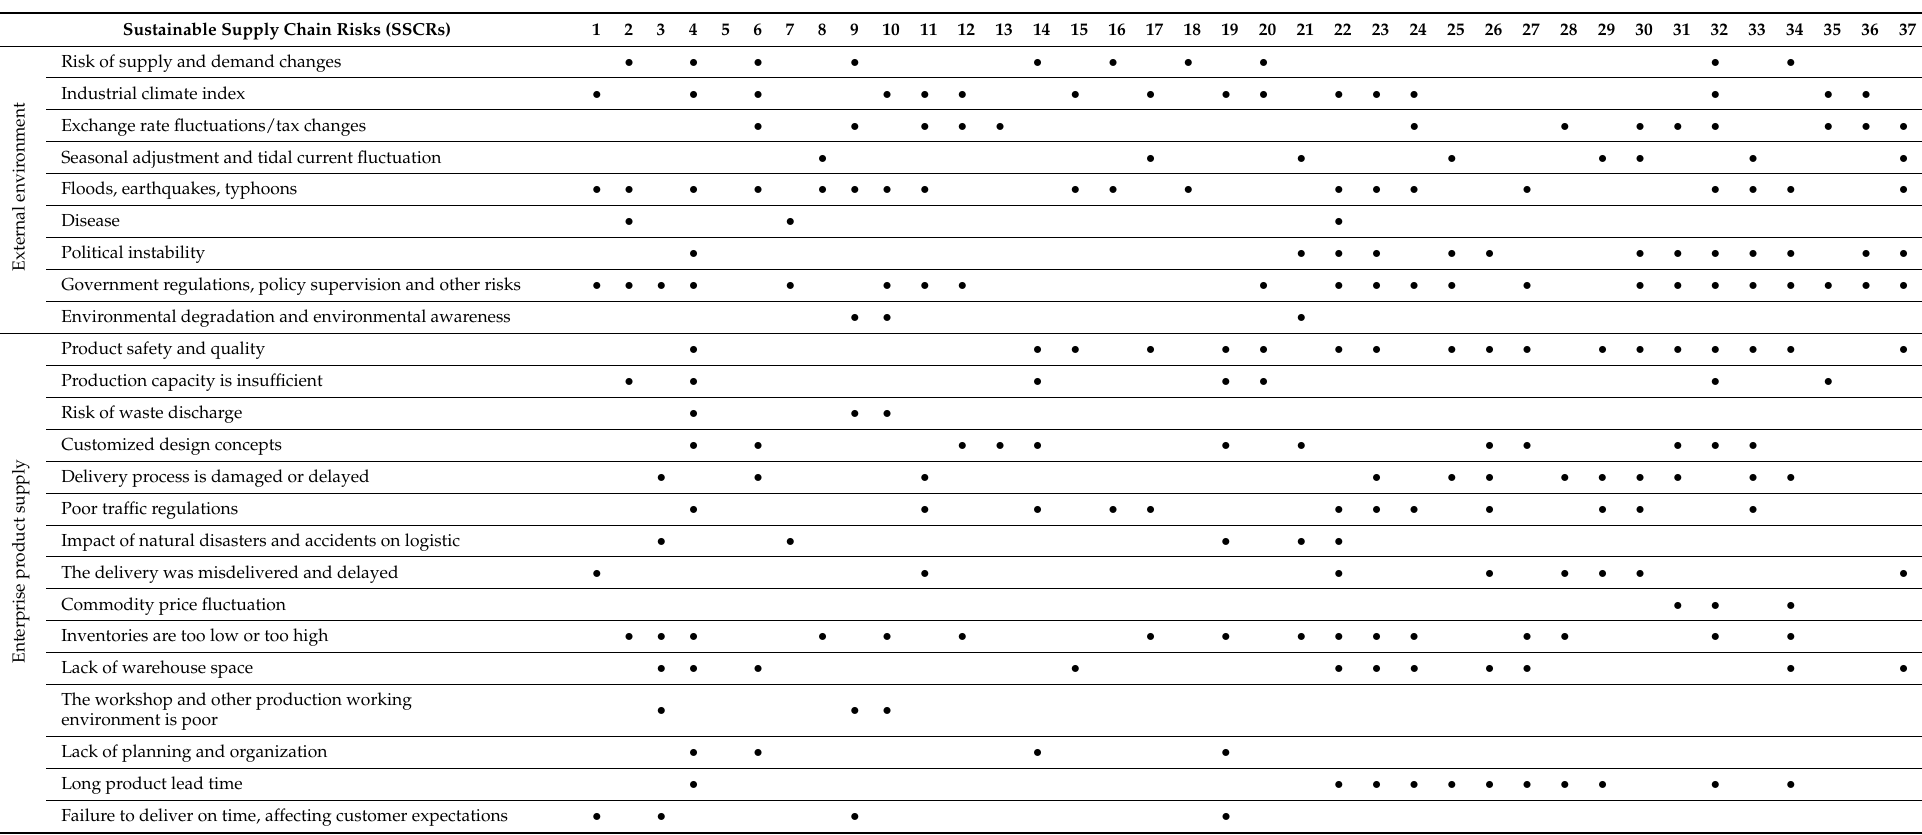
Table A1. Proposed SSCRs by